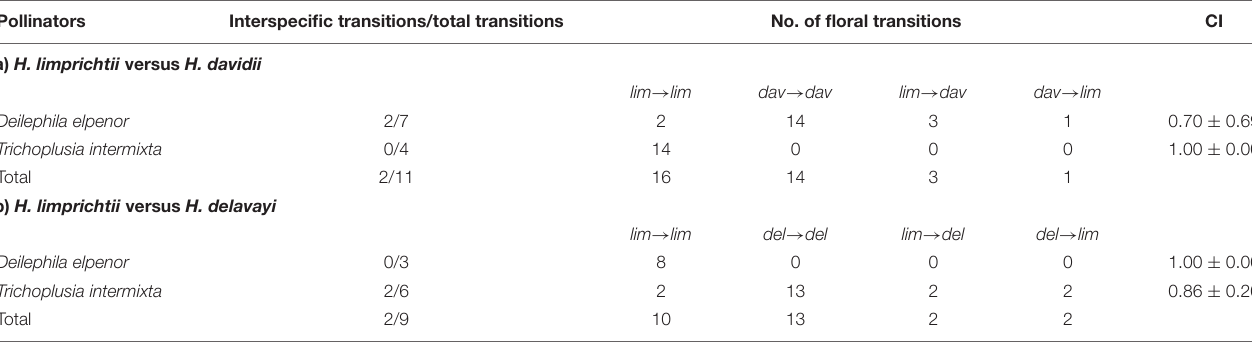
TABLE 1 | Interspecific versus . intraspecific foraging bouts by hawkmoths. Pollinators Interspecific transitions/total transitions No. of floral